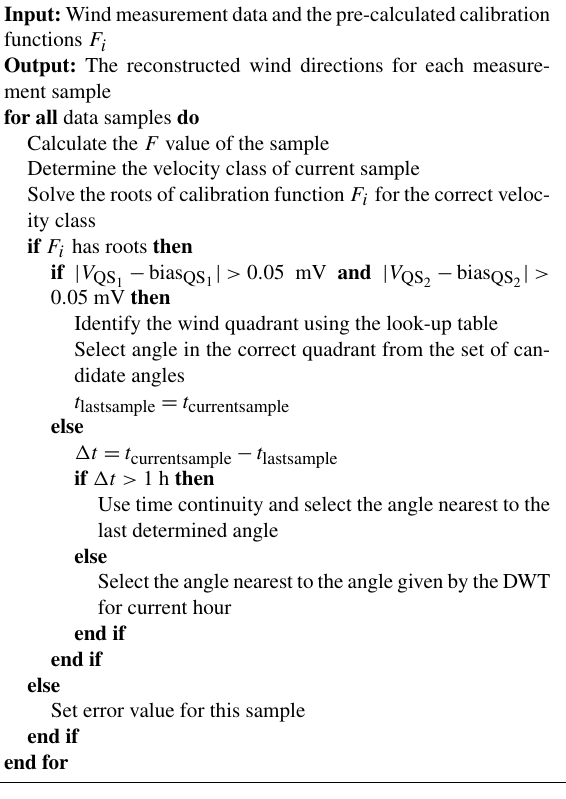
Algorithm 1 The algorithm for wind reconstruction in the first stage (sols 46–377).